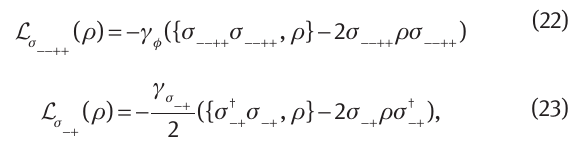
Figure 4: Effect of electron–vibration coupling on resonant surface-enhanced Raman scattering (SERS). (A, B) Incoherent population of the vibrational mode as a function of the laser detuning Δ and vibrational frequency ω vibration coupling (Huang–Rhys) parameter (A) 0.5 d S = = and (B) d = 1. Results are obtained numerically. In both cases, ħ ℰ = 1 meV, and there is no pure dephasing. The straight lines mark the conditions when the peak frequency of one of the bare J-C absorption peaks coincides with the frequency of the incident laser (green line) or with the first-order Stokes line (red line). (C, D) SERS spectra of a molecule = 50 meV, for two values of the electron–vibration coupling, (C) d = 0.5 and (D) d = 1, and supporting a single vibrational mode of energy ħ ω m illumination intensity ħ ℰ = 1 meV and 10 meV. The other parameters used for all the calculations are as follows: ħ γ = 150 meV, ħ g = 100 meV, ħ γ = 0 eV, Δ = δ ħ γ φ a